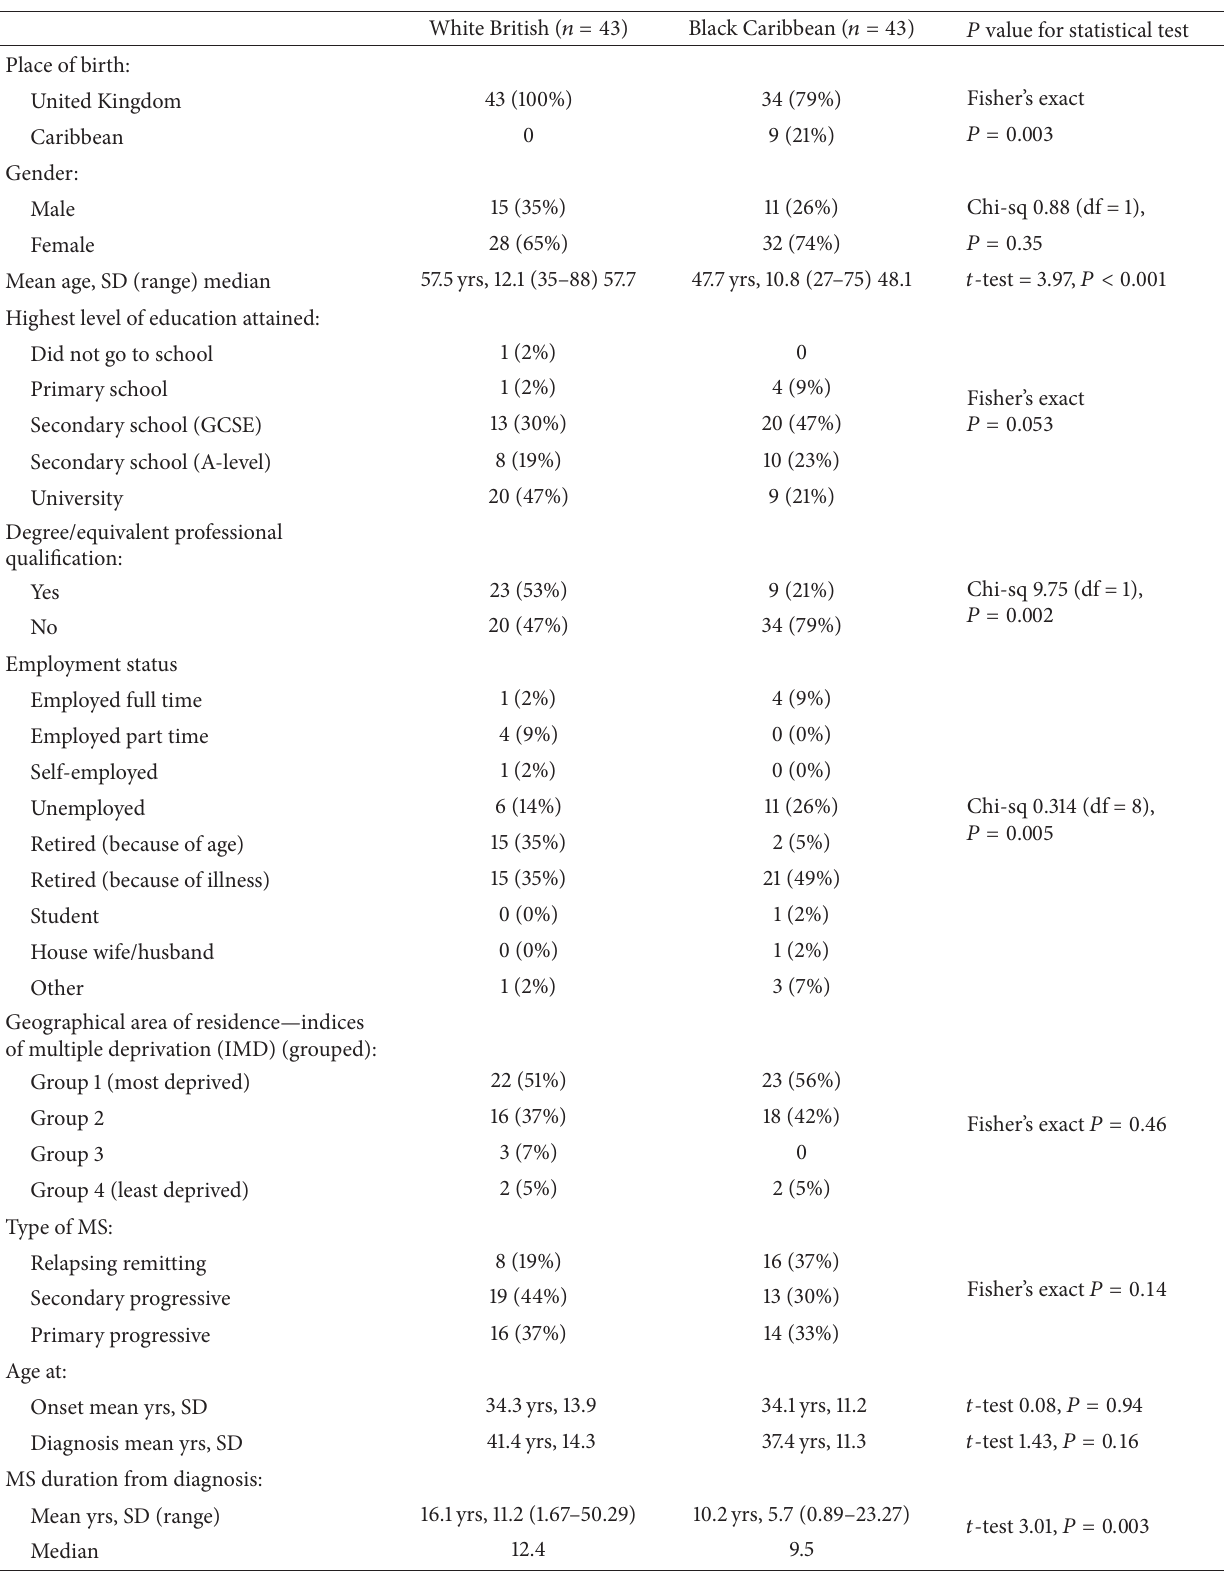
Table 1: Demographic and clinical characteristics of Black Caribbean and White British participants included in the study [15]. White British ( 𝑛 = 43 ) Black Caribbean ( 𝑛 = 43 ) 𝑃 value for statistical